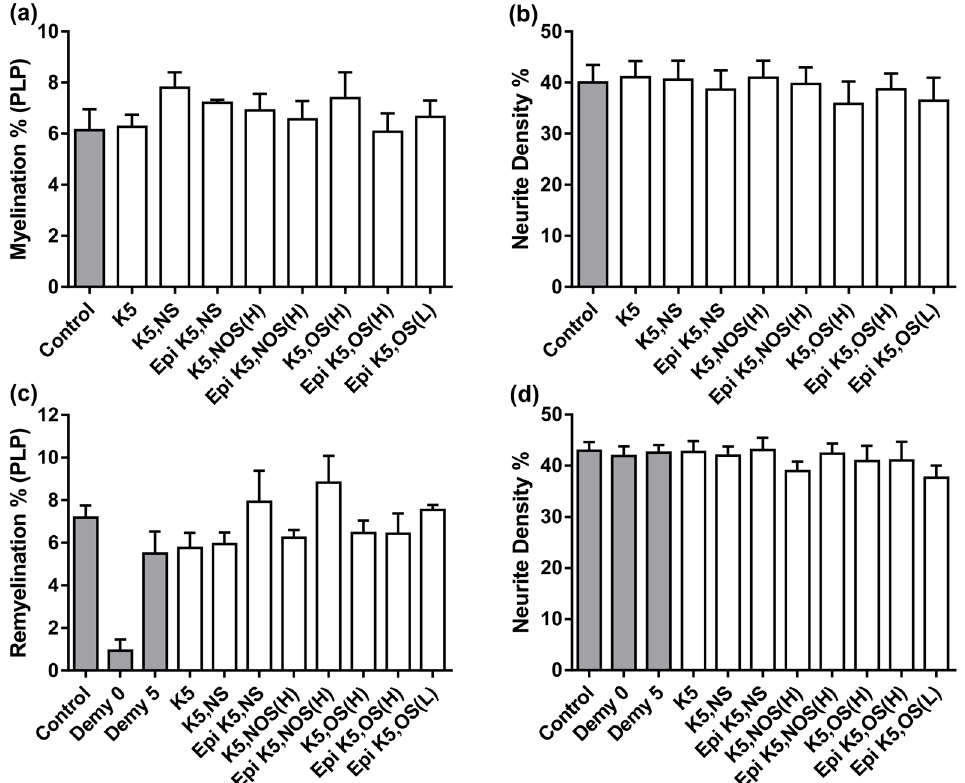
Figure 3. Heparosan screen using MC-Dev and MC-Demy. ( a ) MC-Dev were treated with each heparosan at 1 nM on 13 DIV and 20 DIV and allowed to mature until 24 DIV, at which point they were immunolabelled with SMI31 and PLP. There were no significant differences in the level of myelination found after treatment with any heparosan. ( b ) Quantification of neurite density also demonstrated no effect following treatment with any heparosan. ( c ) MC-Demy were treated with each heparosan at 1 nM on 25 DIV following overnight incubation with anti-MOG and rabbit complement. Quantification of remyelination showed no significant effect following treatment with any heparosan. There was a trend for increased remyelination following Epi K5 NS and Epi K5, NOS (H) treatments compared to the non-treated controls (Demy 5). However, this did not reach statistical significance. ( d ) The quantification of neurite density again showed no change after treatment indicating no adverse toxic effects of any heparosan on the cultures. Error bars + SEM (one-way ANOVA with Dunnett multiple comparison n = 4; technical replicates = 3).